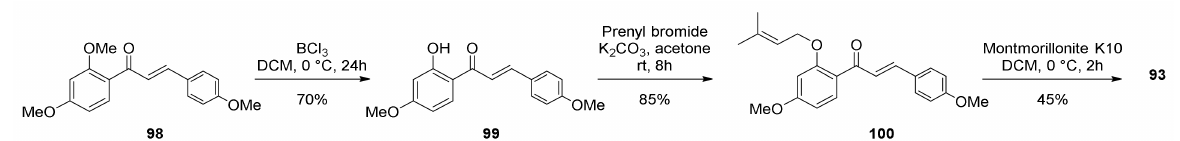
Figure 29. Synthesis of prenylated chalcone dienophile 93 .